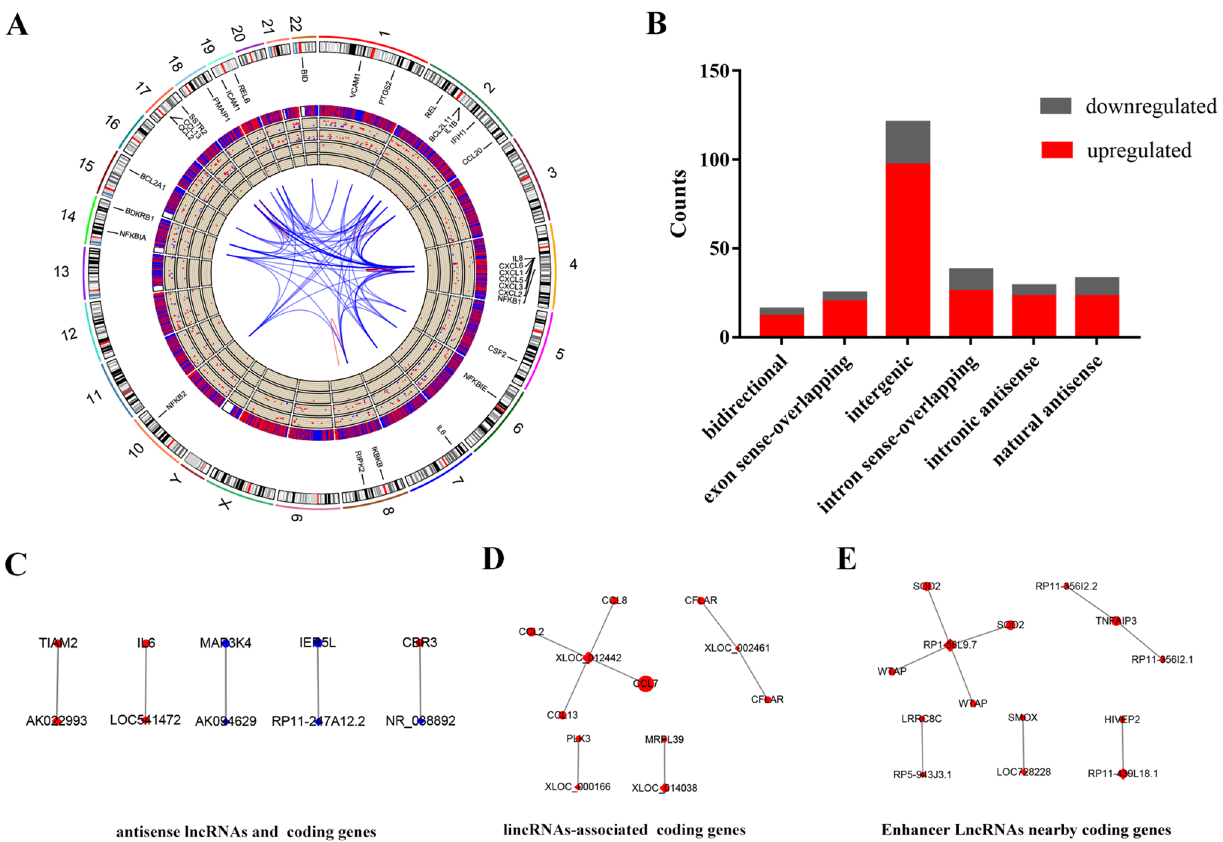
Figure 2. Identification of changes in lncRNA and mRNA expression profiles in SFMSCs after IL-1β stimulation for 2 h. ( A ) Circos plot showing differentially expressed lncRNAs and mRNAs on chromosomes. The first layer represents the chromosome map of the human genome. The top 30 K-score transcripts in the co-expression network of differentially expressed mRNAs are labeled in the second circle. Differentially expressed lncRNAs (blue) and mRNAs (red) with fold changes ≥ 1 are labeled in the third circle. The fourth and fifth circles represent the mean expression values of lncRNAs and mRNAs with fold changes ≥ 2 and P < 0.05. Red points represent upregulation, and blue points represent downregulation. The sixth and seventh circles represent mean expression values of lncRNAs and mRNAs with fold changes ≥ 10 and P < 0.05. Red points represent upregulation, and blue points represent downregulation. The innermost layer indicates the interaction network of the top 30 K-score transcripts labeled in the second circle. Red lines indicate linked transcripts in the same chromosome, and blue lines represent those on different chromosomes. Analysis was performed using R Software created by R Core Team (2020). R: A language and environment for statistical computing. R Foundation for Statistical Computing, Vienna, Austria. https:// www.R- proje ct. org/. ( B ) Categories of lncRNAs according to the genomic loci of their neighboring genes. ( C ) Differentially expressed antisense lncRNAs and their associated coding genes. ( D ) Differentially expressed lincRNA and associated coding gene pairs (distance < 300 kb). ( E ) Differentially expressed enhancer-like lncRNAs and their nearby coding genes (distance < 300 kb); both the lncRNA and its paired mRNA showed fold changes ≥ 2 and P < 0.05 among all differentially expressed lncRNAs and mRNAs. Diamonds represent lncRNAs, and circles represent mRNAs; red represents upregulation, and blue represents downregulation; different sizes represent the absolute value of the fold change. Protein names were used to label the genes in ( A ); Genesymbol was used to label the genes in ( C – E ). Images ( C – E ) were created using CytoScape 3.8.0 Software. exon sense-overlapping: the LncRNA’s exon is overlapping a coding transcript exon on the same genomic strand; intronic: the LncRNA is